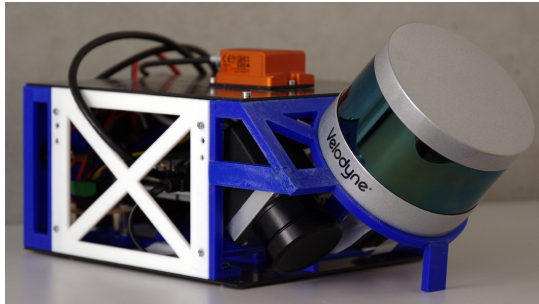
Figure 12. Prototype of the mapping module.